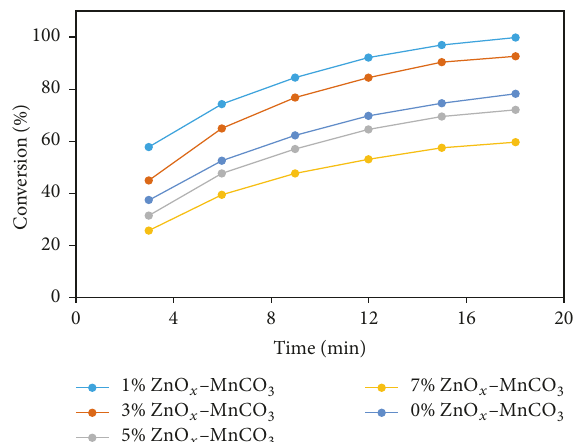
Figure 8: Theeffect of different weight % ZnO